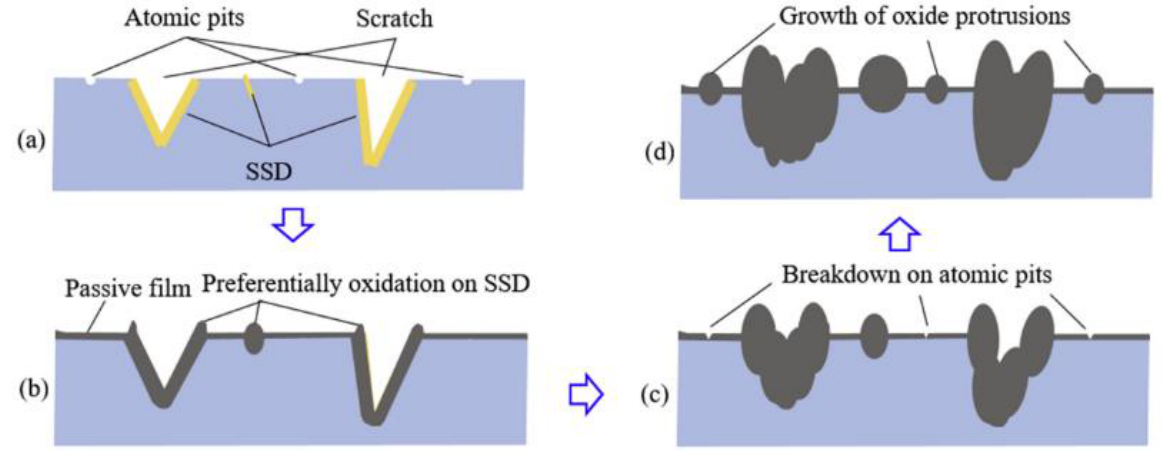
Figure 25. Modeling of the anodic oxidation process of the 4H-SiC surface: ( a ) the original surface; ( b ) the initial stage of anodic oxidation; ( c ) the second stage of anodic oxidation; ( d ) the final stage of anodic oxidation [57] .